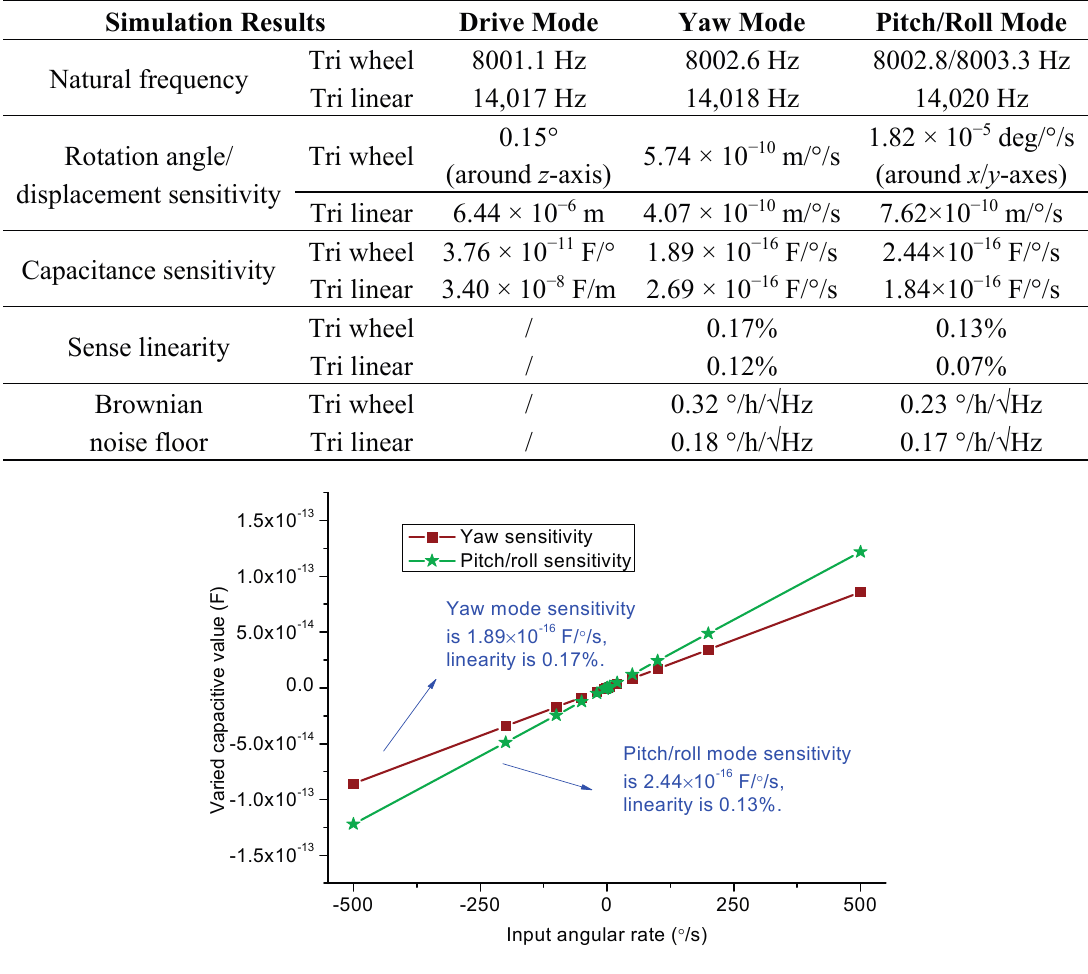
Table 11. Simulation result summary and comparison.